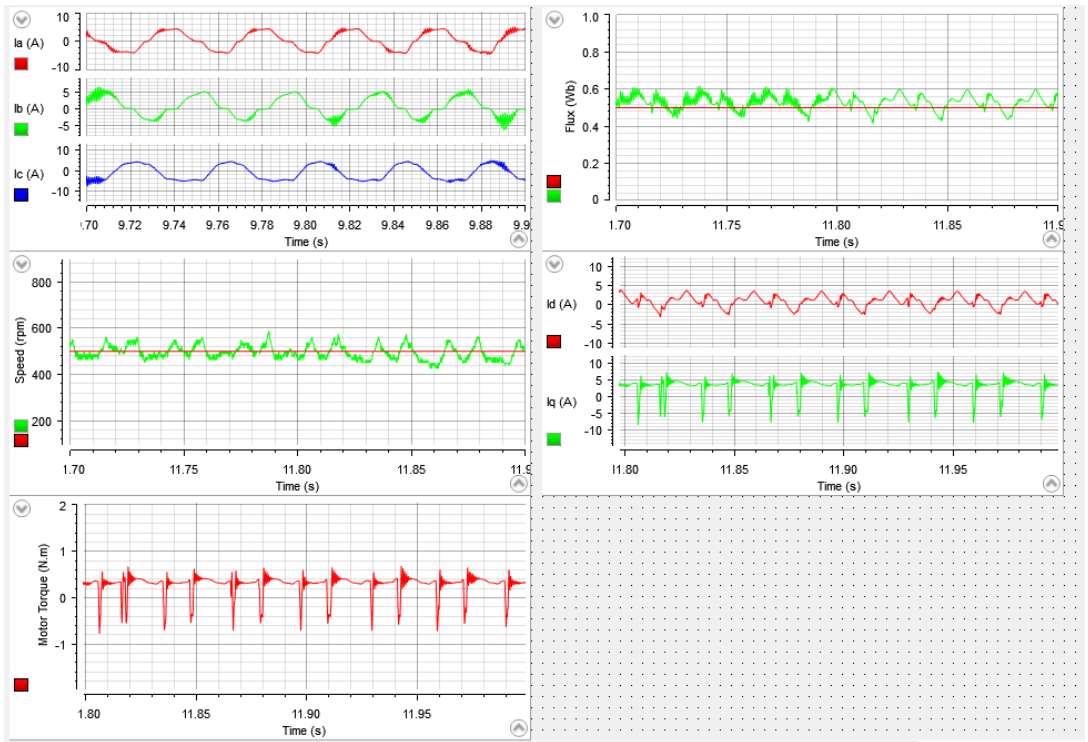
Figure 9. The PMSM performance during steady